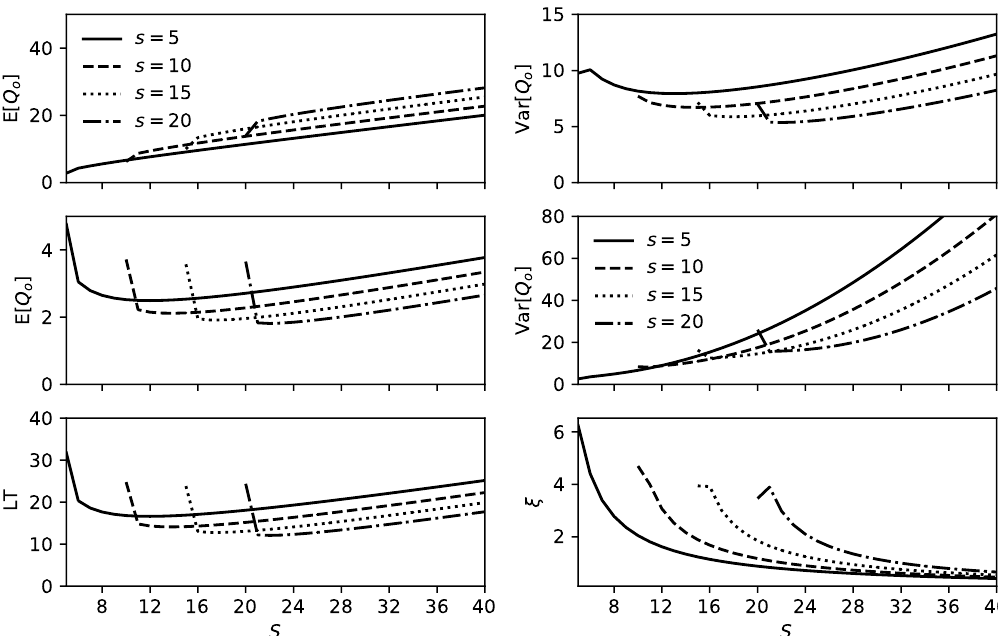
Figure 4. Mean of the order backlog, the inventory level and the lead time vs. the inventory size S for different values of the threshold s ( left ) and variance of the inventory level and order backlog and setup rate vs. the inventory size S for different values of the threshold s ( right